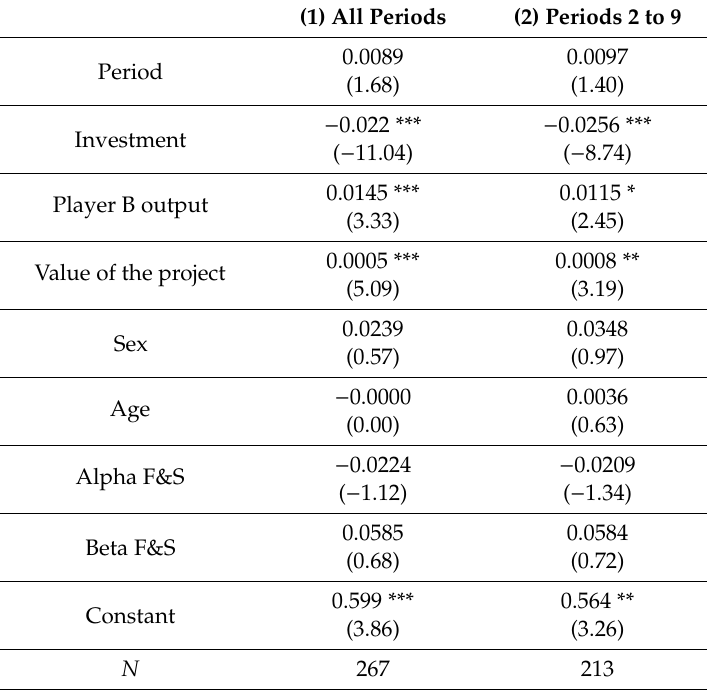
Table 2. Regression for player C’s decision in the FREE